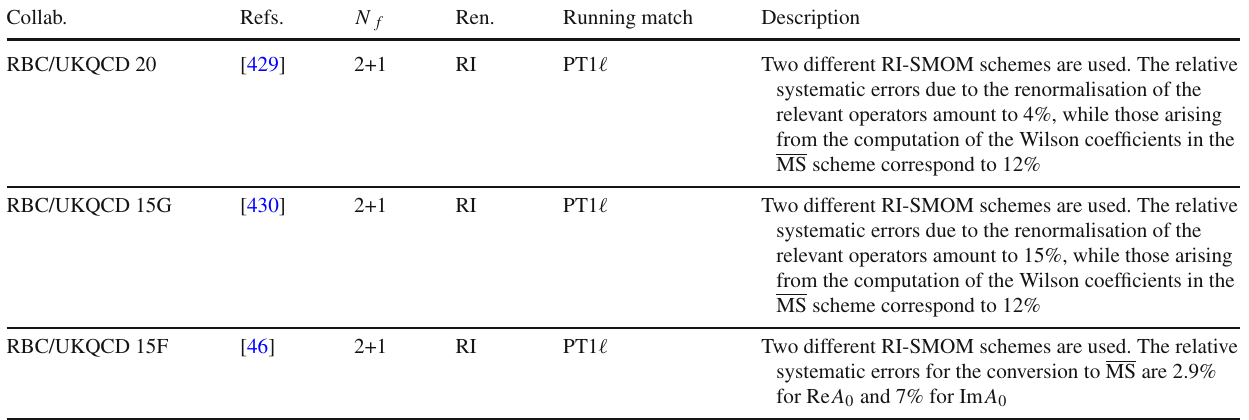
Table 124 Running and matching in determinations of the K → ππ decay amplitudes Collab.